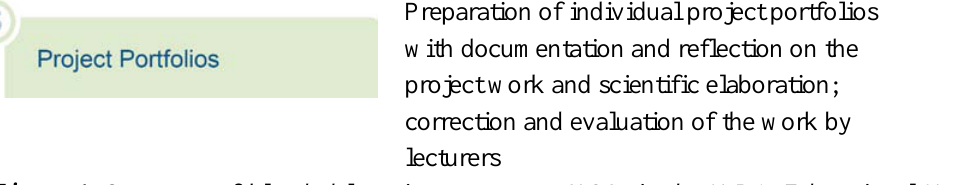
Figure 1 . Structure of blended learning courses at UOL in the MBA Educational Management